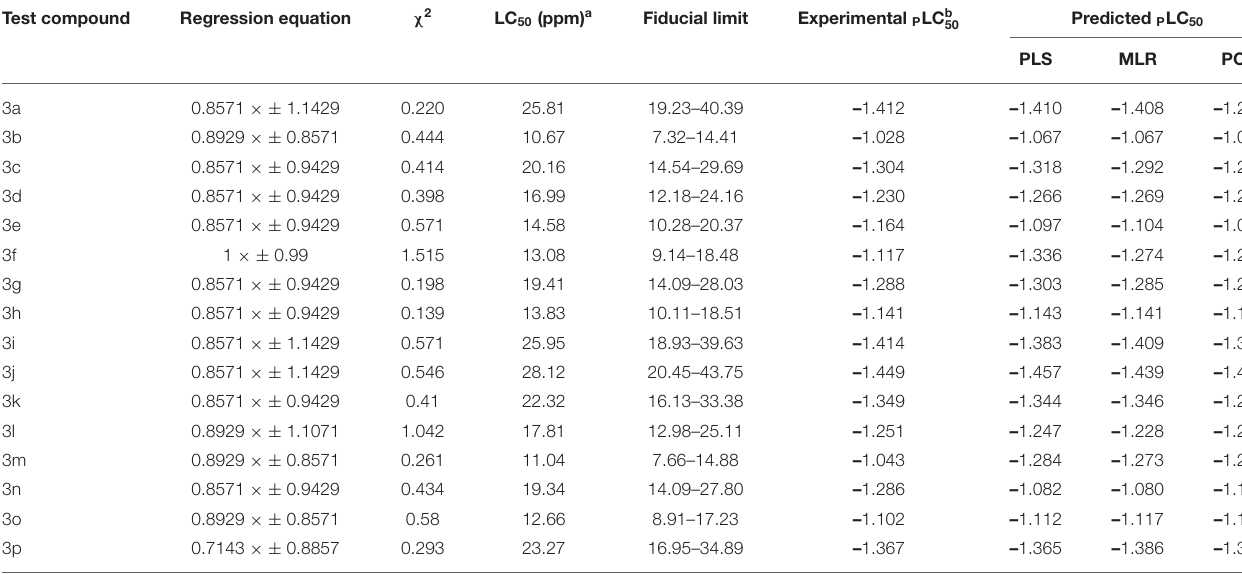
Table 4A | Experimental and predicted nematicidal activity of ferrocenyl chalcones against M. incognita . Test